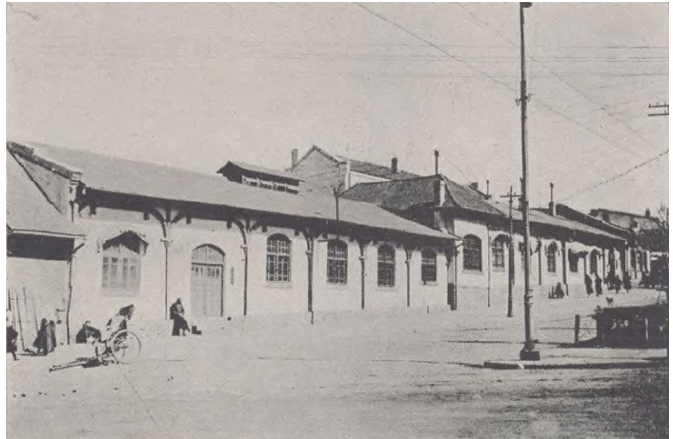
Figure 6. The Initial Trading Market of Qingdao Exchange (source: [39]). From its establishment to the early 1930s, the Qingdao Exchange Building basically monopolized the trading market of agricultural products and main goods until Qingdao Commodity Stock Exchange was set up by Chinese merchants with the support of the municipal authorities in 1931. After the outbreak of the Second World War, Japan’s excessive involvement in foreign wars led to an extreme shortage of materials, and circulation was restricted. In 1944, the Qingdao Exchange Building was forced to close